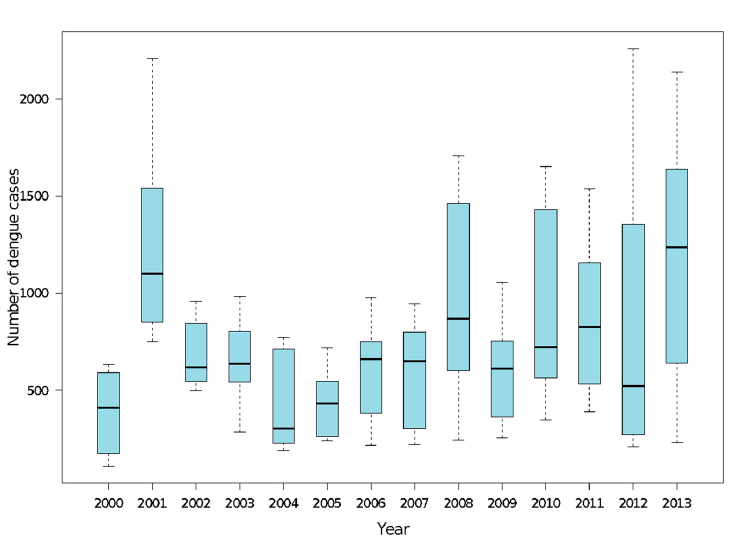
Figure A1. Median and interquartile range of the monthly reported cases of dengue by year in Bangkok, Thailand over 2000–2013. Table A1. Summary of the socio-economic variables and their definitions.